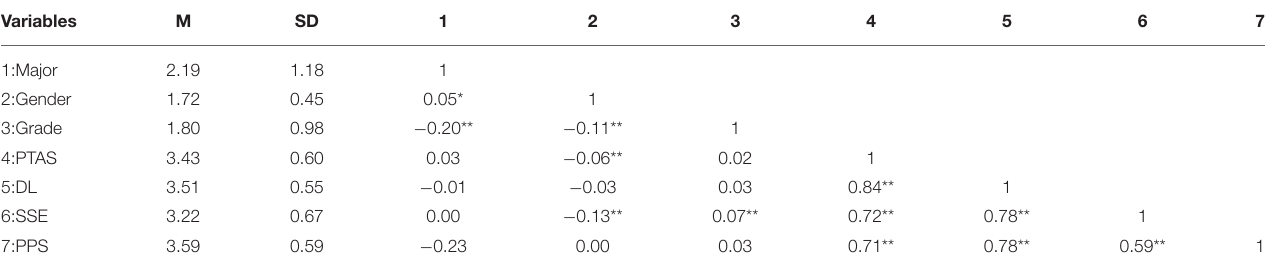
TABLE 1 | Descripetive statistics and correlation among variables. Variables